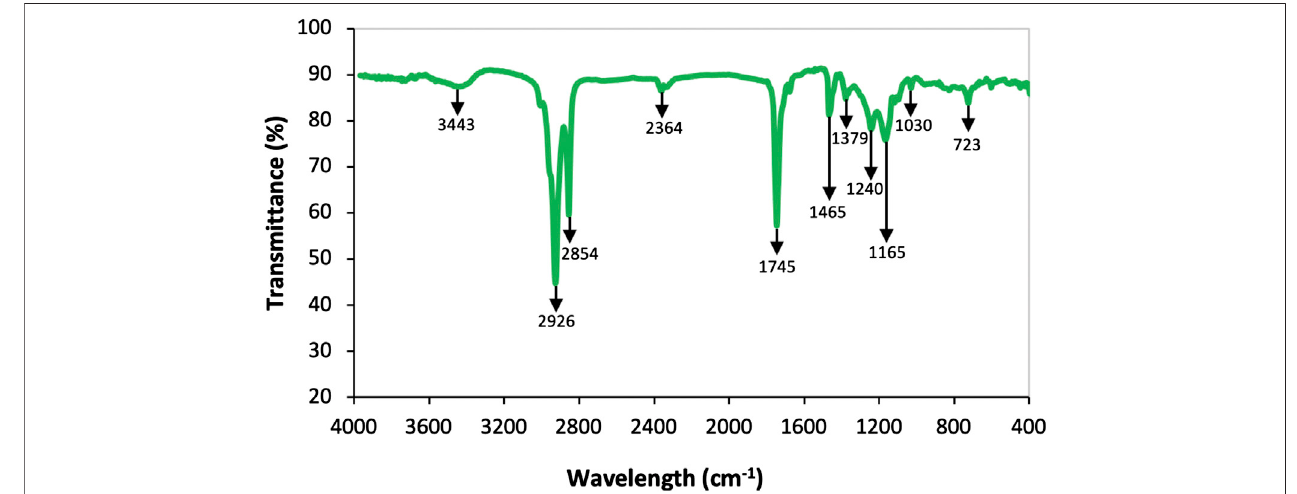
FIGURE 1 | FTIR spectrum for the NSO.